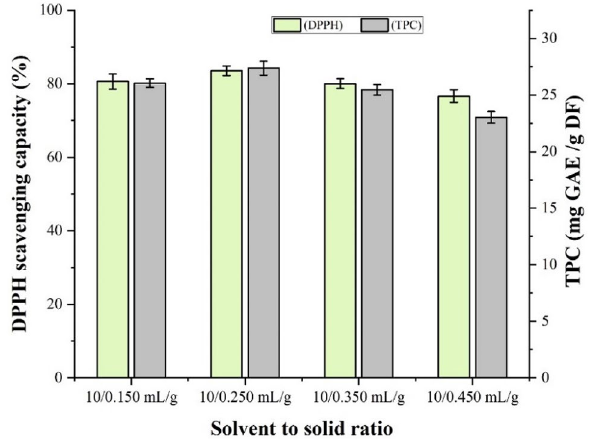
Figure 4. Effect of solvent to solid ratio on the antioxidant and TPC of fruits of Ficus auriculata extracted with 75% ethanol. Data are presented as mean ± SD from triplicate experiments.